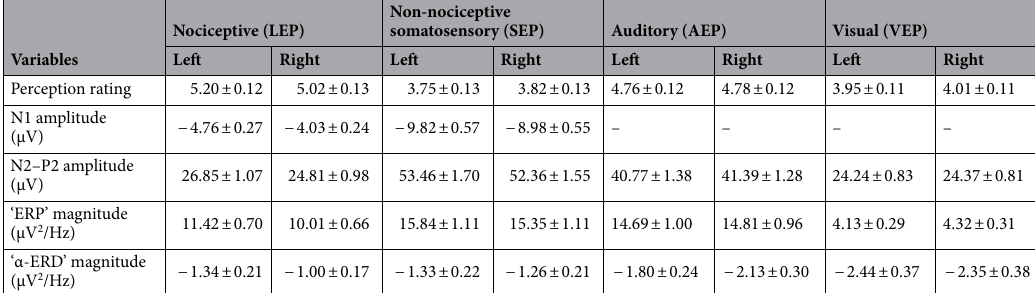
Table 1. Subjective ratings of perceived intensities, N1 and N2–P2 amplitudes, as well as ‘ERP’ and ‘α-ERD’ magnitudes elicited by nociceptive somatosensory (LEP), non-nociceptive somatosensory (SEP), auditory (AEP), and visual (VEP) stimuli that were delivered to the left and right sides (data are expressed as mean ± SEM). LEP laser-evoked potentials, SEP somatosensory-evoked potentials, AEP auditory-evoked potentials, VEP visual-evoked potentials.